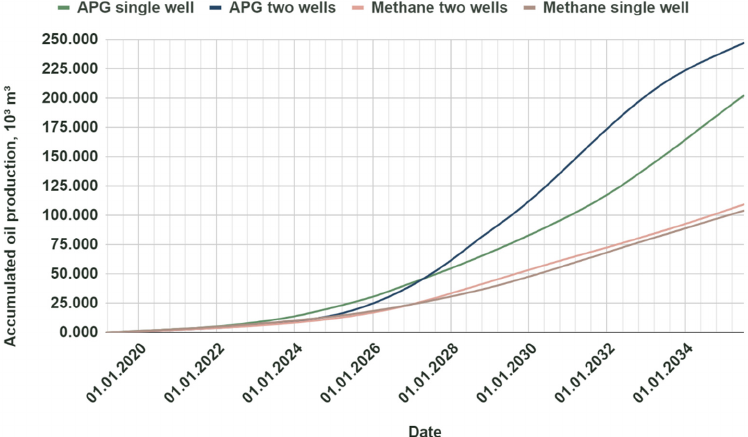
Figure 10. Accumulated oil